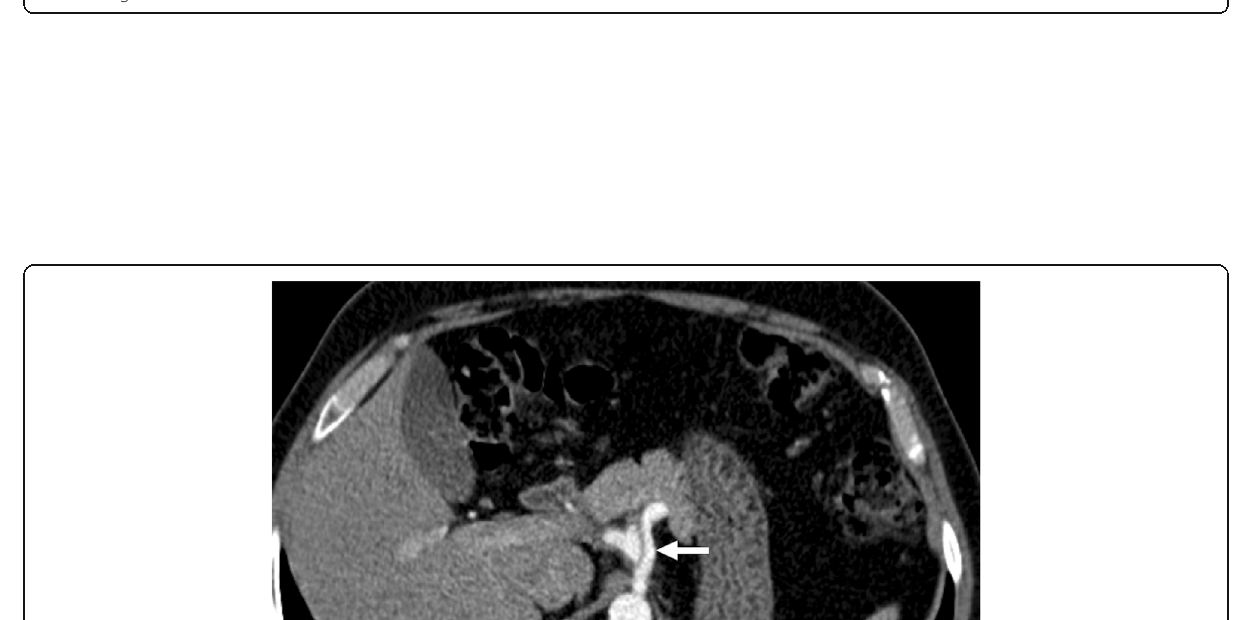
Fig. 24 SMA syndrome. A 37-year-old female with no past medical history presented to ED with severe nausea and vomiting. Physical examination revealed a significantly distended abdomen. a Coronally reformatted post-contrast CT image demonstrates a severely distended stomach and proximal duodenum. b Sagittal post-contrast CT image showed markedly decreased aortomesenteric angle and aortomesenteric distance. Findings were found to be consistent with SMA syndrome. Endoscopic study confirmed this diagnosis and revealed no evidence of obstructing endoluminal mass